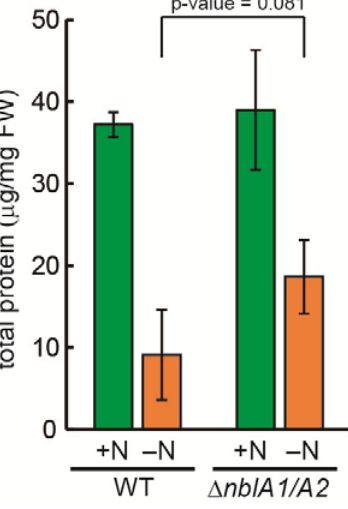
Figure 6. Total amount of cellular protein in WT Synechocystis and the nblA1/A2 mutant ( ∆ nblA1/A2 ) after 24 h in nitrogen-sufficient (+N) or nitrogen-deficient (–N) medium. Standard deviation is shown from three independent